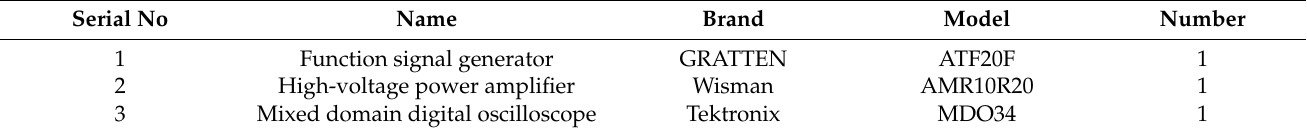
Table 1. Main experimental equipment and apparatus required for the actuation mechanism experi- ment of flexible actuator based on PAM conductive hydrogel